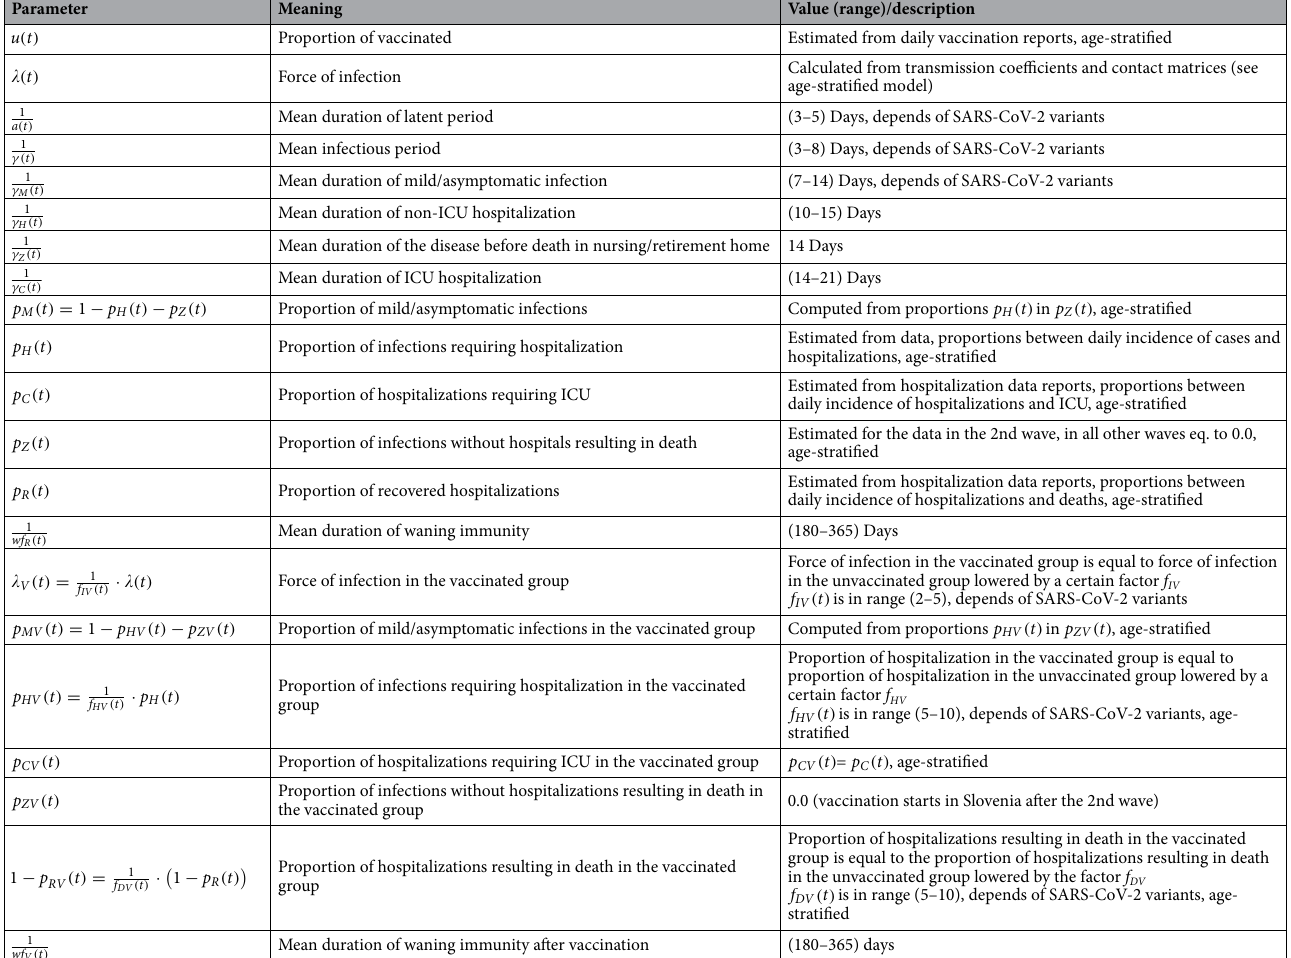
Table 1. The parameters of the model. All parameters are functions of